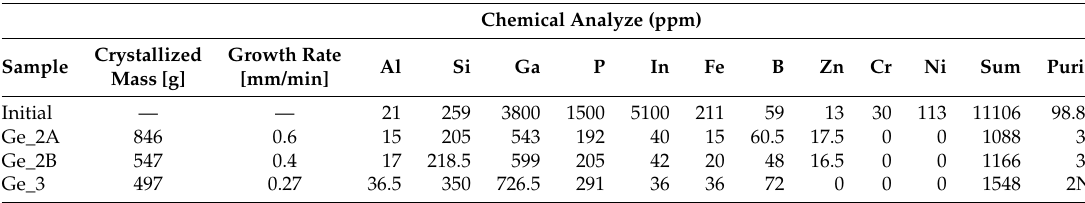
Table 4. Chemical analysis of germanium crystallization